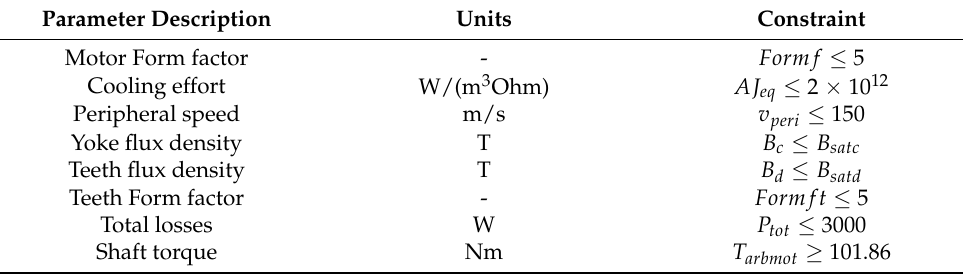
Table 5. Optimization constraints for SM.